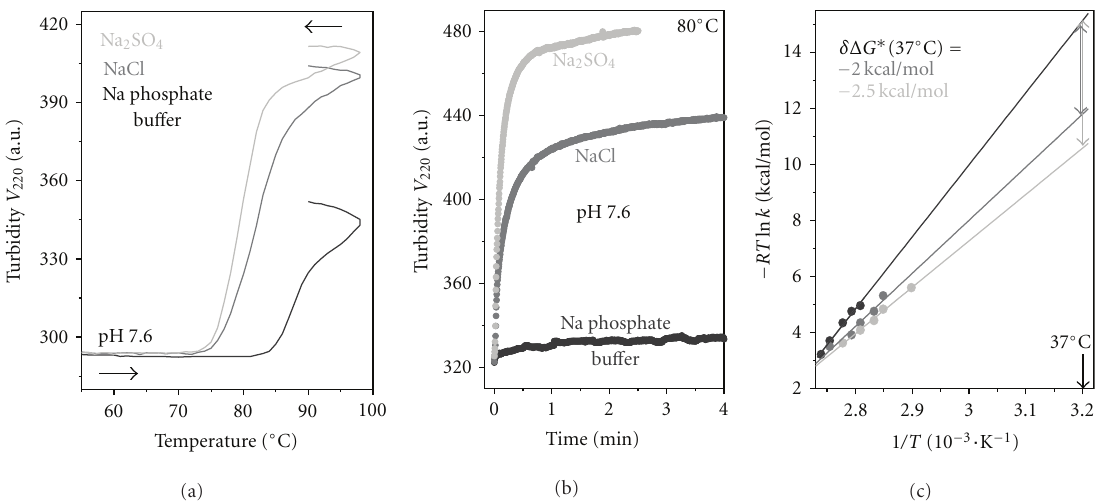
Figure 7: E ff ects of Na salts on thermal stability of VLDL. VLDL solutions (0.1mg/mL protein concentration, 5 mM Na phosphate bu ff er, pH 7.6) containing bu ff er alone (black) or together with 10mM NaCl (grey) or Na 2 SO 4 (light grey) were subjected to melting (a) or kinetic experiments ((b) and (c)). The melting data were recorded by turbidity during sample heating at a constant rate of 11 ◦ C/h (a). The kinetic data were recorded in T -jumps from 25 ◦ C to higher temperatures, such as 85 ◦ C (b). Arrhenius analysisof the T -jump data showsthat, similar to Na phosphate (Figure 6(b)), increasing the NaCl or Na 2 SO 4 concentration leads to a decrease in the slope of the Arrhenius plot, indicating a decrease in the activation energy E a . Linear extrapolation of the Arrhenius plots suggests that the kinetic stability of VLDL at 37 ◦ C decreases by about 2 kcal/mol upon addition of 10mM NaCl and by about 2.5kcal/moL upon addition of 10mM Na 2 SO 4 (double